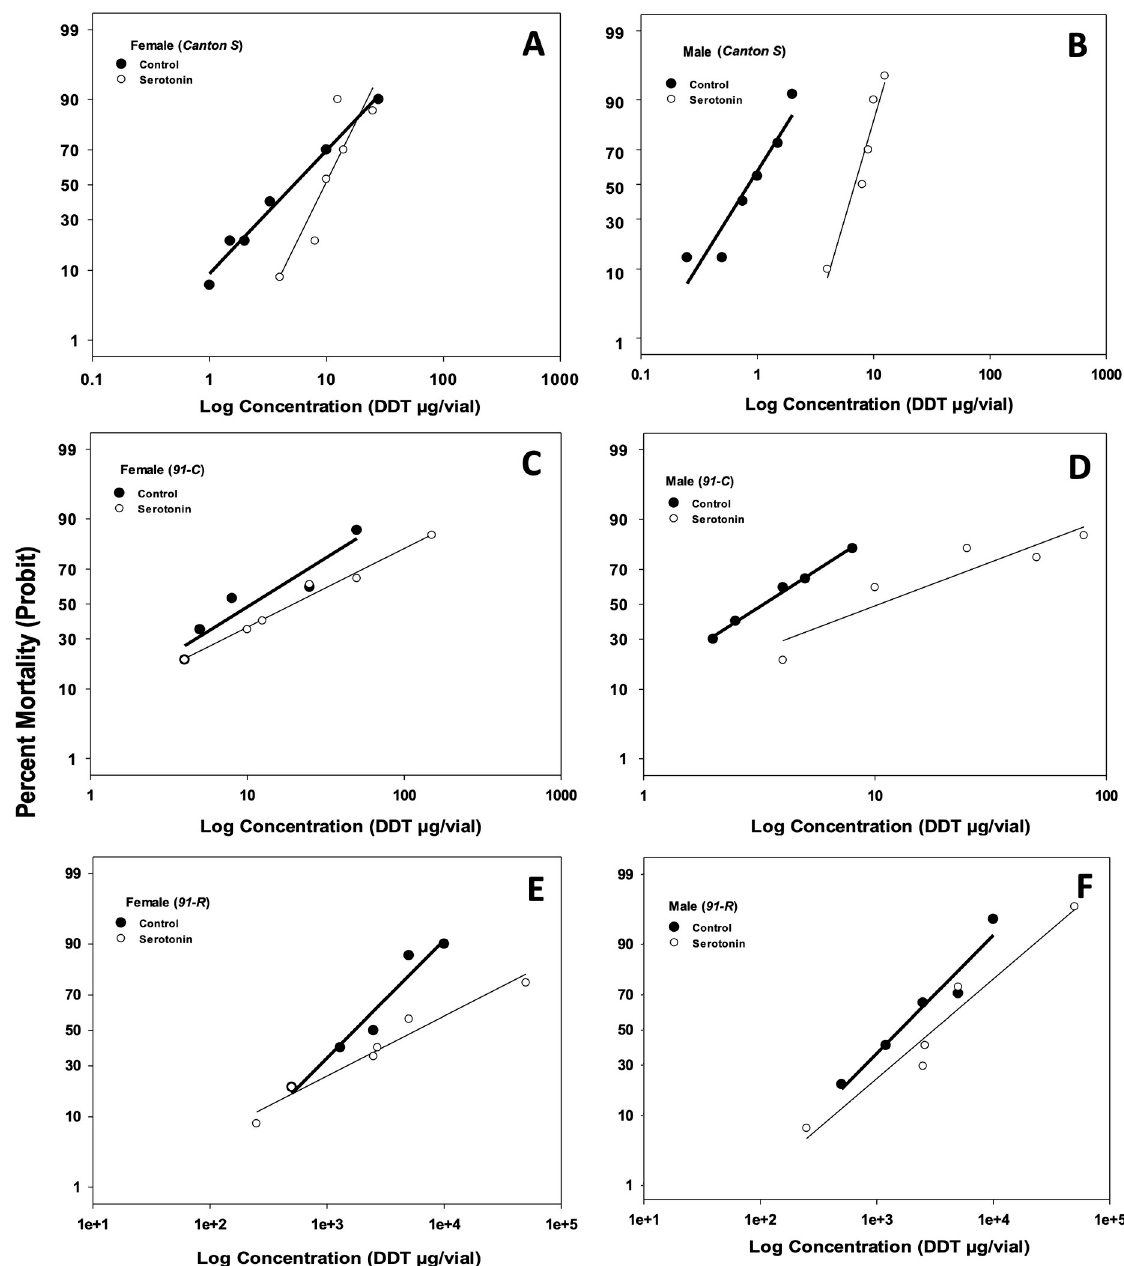
Fig 1. Dose response curves for DDT toxicity for females and males of Canton-S (A and B), 91-C (C and D), and 91-R (E and F) strains of Drosophila melanogaster raised on blue diet containing serotonin. Adults (6–8 days old) were exposed to different doses of DDT and mortality was determined at 24 h of exposure. Data were analyzed using probit analysis in SPSS (Chicago, IL, USA). For each dose, 3–4 replicates were